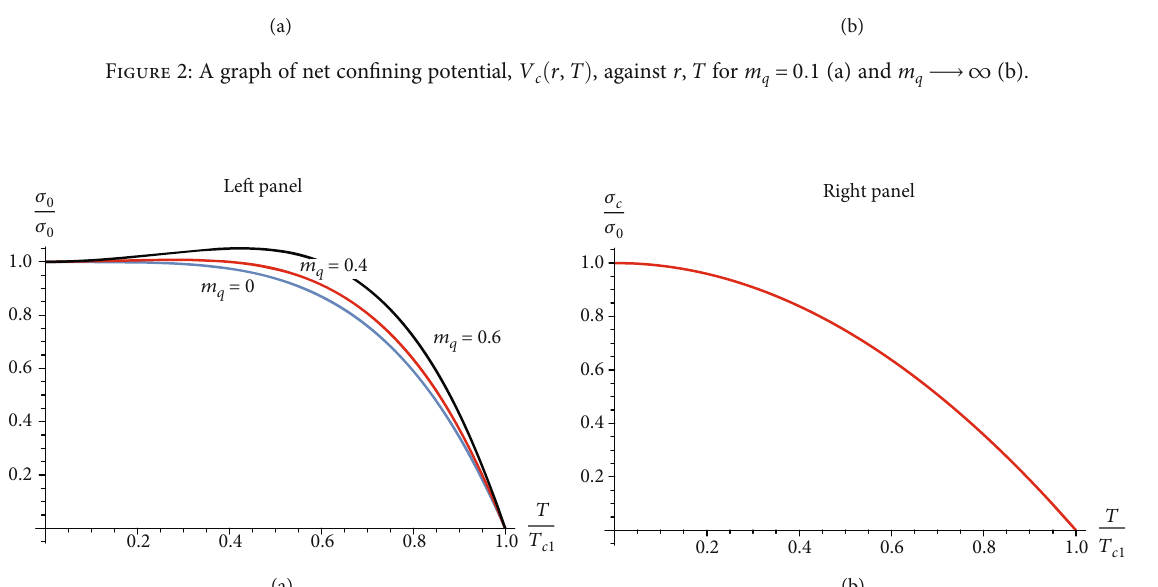
Figure 3: A graph of string tension, σ